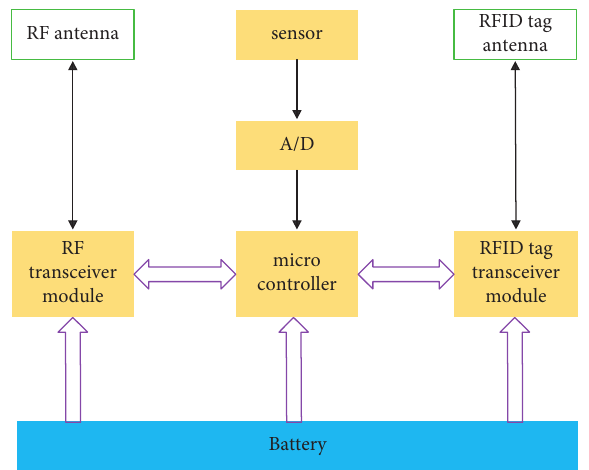
Figure 4: RFID electronic tag and wireless sensor fusion